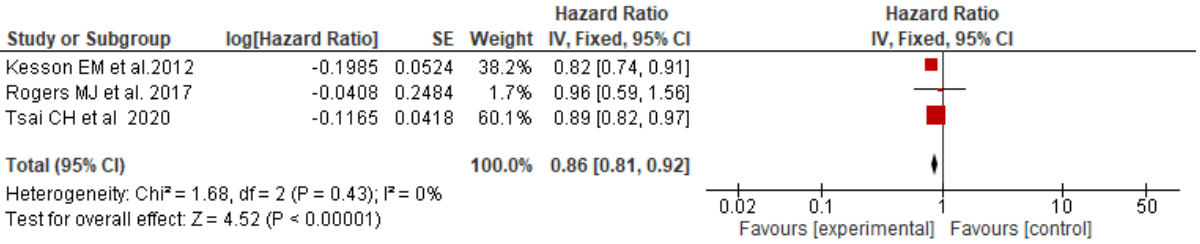
Figure 2. Forest plot of adjusted HRs for breast cancer mortality among patients enrolled (experi- mental) vs. not enrolled (control) in MTBs